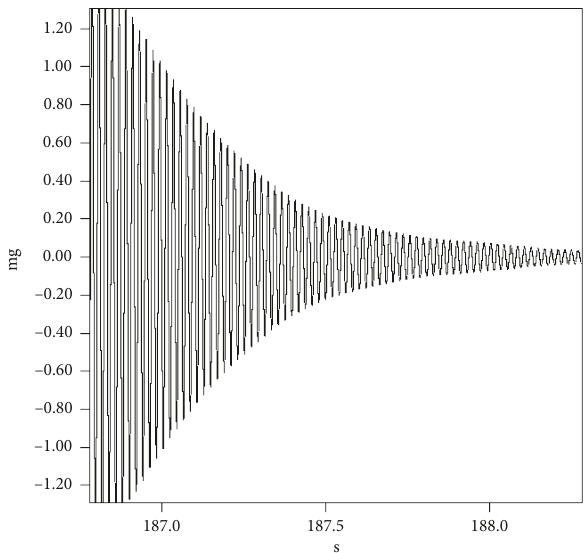
Figure 18: Curve of damping